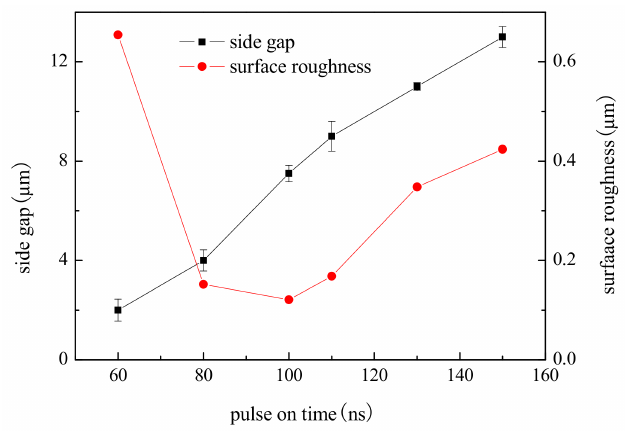
Figure 7. Effect of pulse on time on side gap and surface roughness.